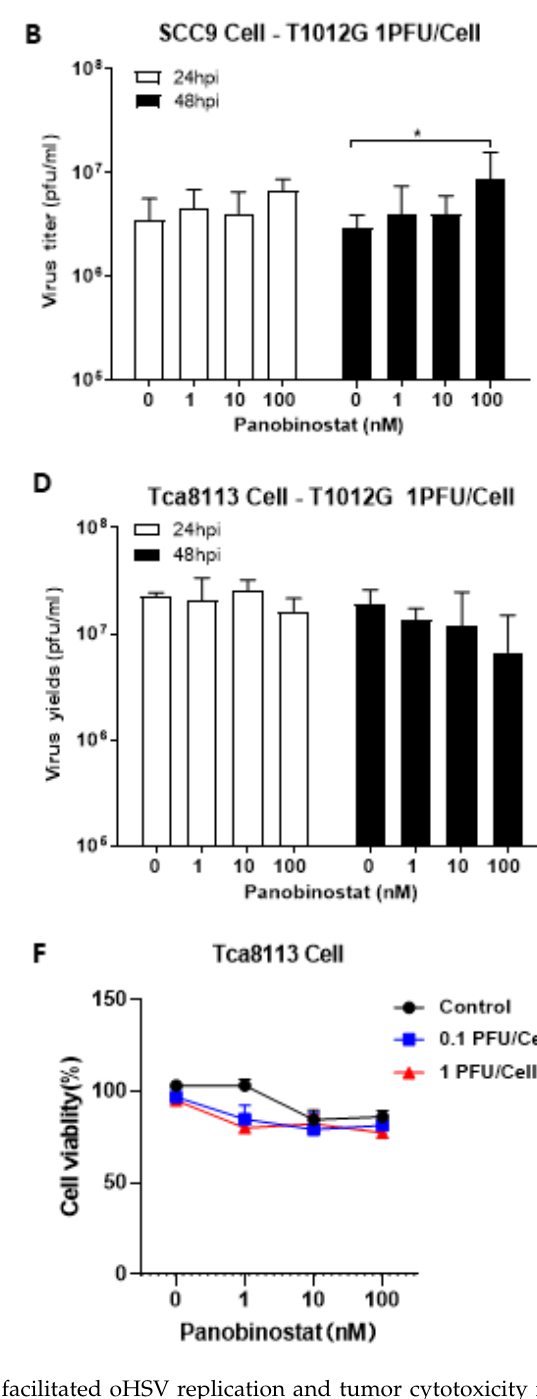
Figure 2. Panobinostat treatment facilitated oHSV replication and tumor cytotoxicity in human squamous cell carcinoma SCC9 cells. Human squamous cell carcinoma SCC9 ( A , B ) and Tca8113 cells ( C , D ) were pretreated with panobinostat (1, 10, or 100 nM) for 14 h and then infected with T1012G (0.1 or 1 PFU/Cell) for another 48 h, respectively. The infected cell pellets were harvested at 48 hpi. The titration was measured by conventional plaque assay on Vero cells after three freeze–thaw cycles. The cytotoxicity activity was assessed using a CCK8 assay. SCC9 ( E ) and Tca8113 ( F ) cells were mock- or pretreated with panobinostat as above, following infection with T1012G for 48 h. The cell viability of the infected cells was measured with a CCK8 assay (mean ± SD). The assay was performed in triplicate. Differences between datasets were assessed by Student’s t -test (two-tailed) using GraphPad Prism software. * p < 0.05 and ** p < 0.01.